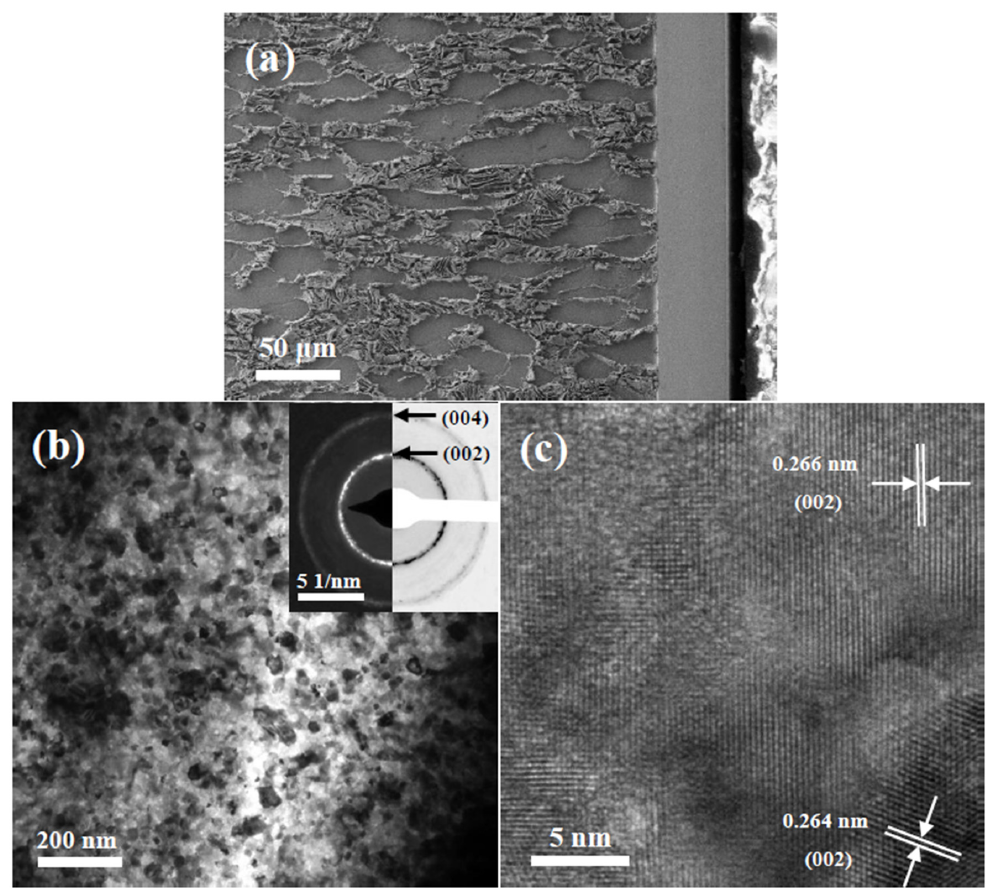
Figure 3. ( a ) Secondary electron cross-sectional image; ( b ) plan-view TEM bright-field image and corresponding SAED pattern; and ( c ) HRTEM image of the as ‐ deposited β‐ Ta coating.